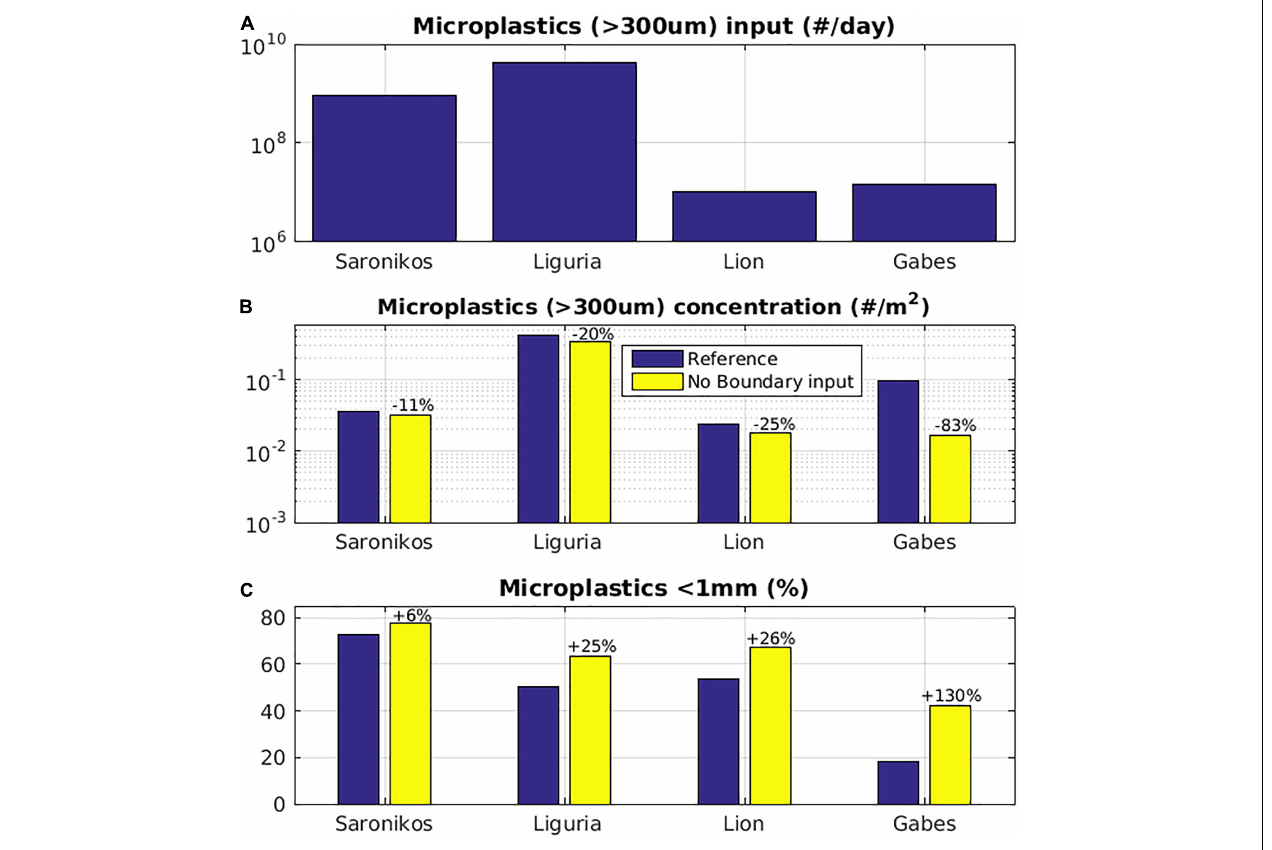
FIGURE 10 | Microplastics (A) total input (items/day), mean (2018–2019) microplastics (B) concentration (items/m 2 ) and (C) contribution < 1 mm (%) in the four key study areas (Saronikos Gulf, Ligurian Sea, Gulf of Lion, and Gabes Gulf) with the fine-model reference simulation (blue bar) and a simulation without microplastics input from the open boundaries (yellow